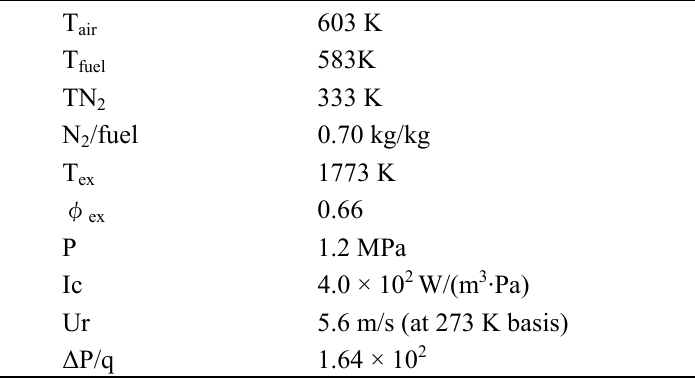
Table 9. Standard test conditions.